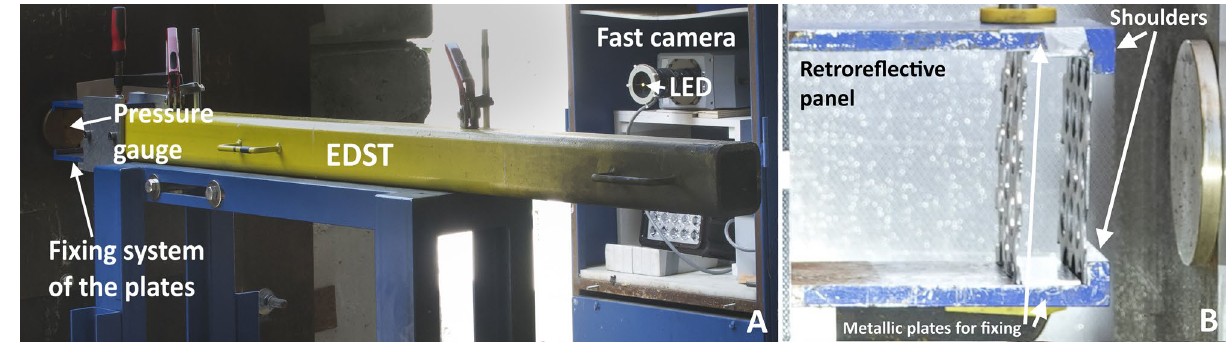
Fig. 5 A Experimental setup showing the explosive driven shock tube and the fast camera with the LED. B Detail of the metallic plates used for the fixing of the